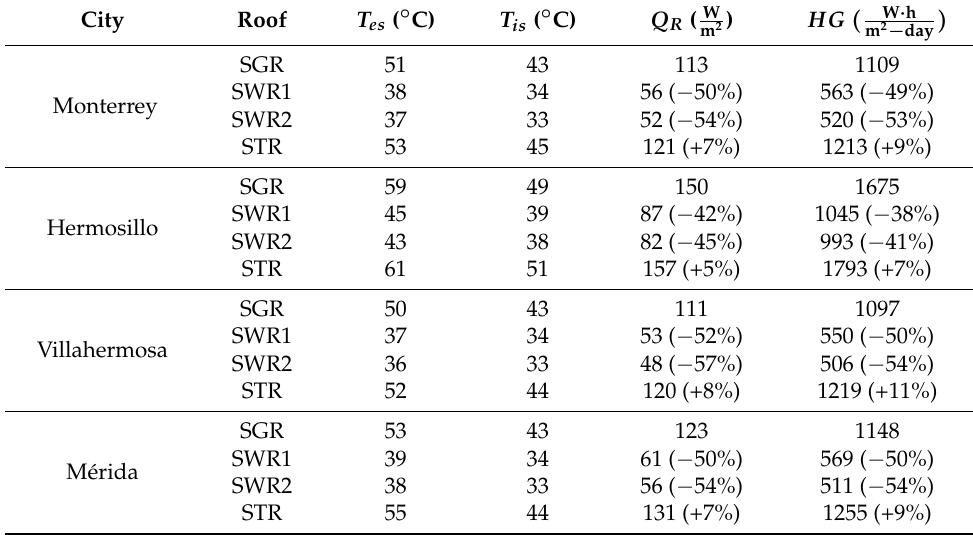
Table 3. Summary of the thermal evaluation of a single roof in four cities of Mexico (Average peak values for the different